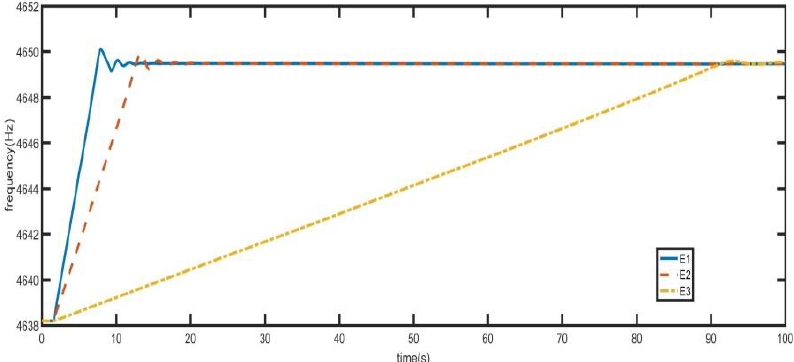
Figure 18. Vibration frequencies of driving modes under different parameters.